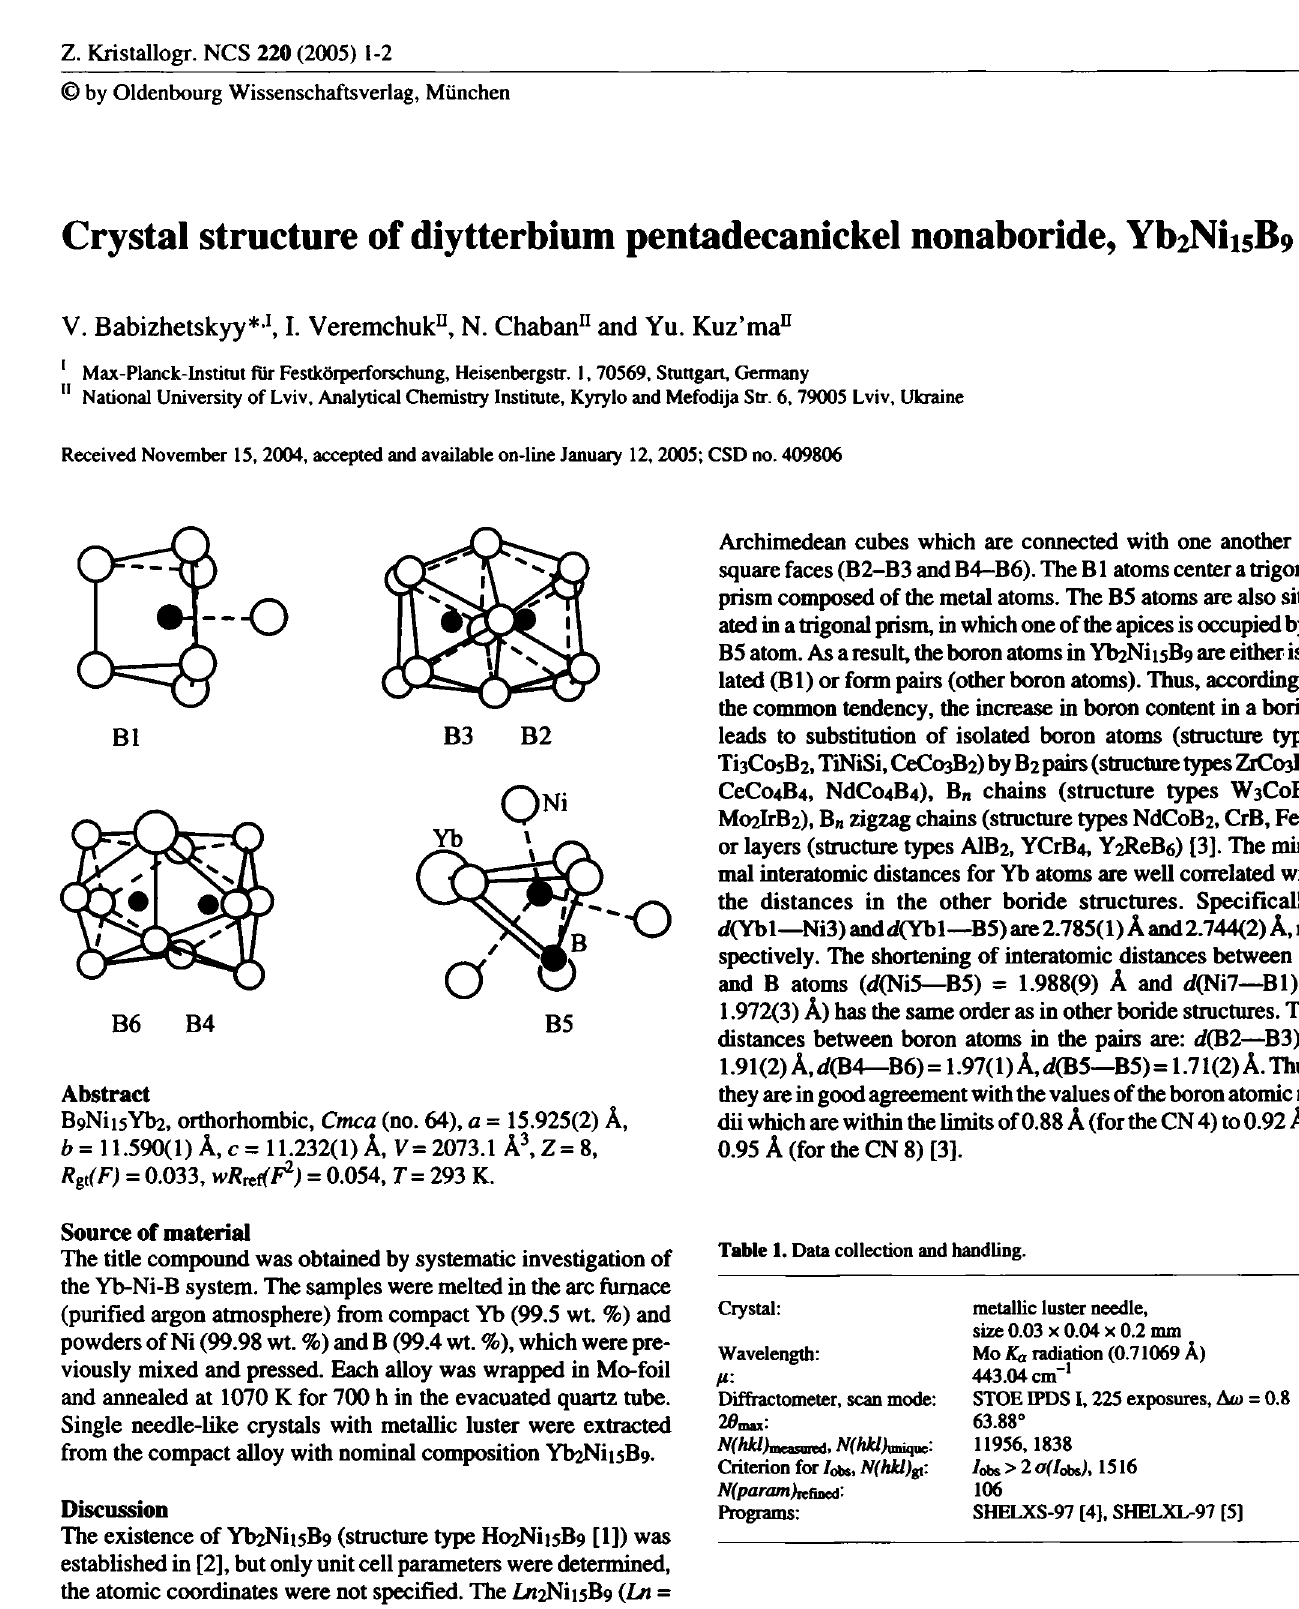
Table 2. Atomic coordinates and displacement parameters (in Ä 2